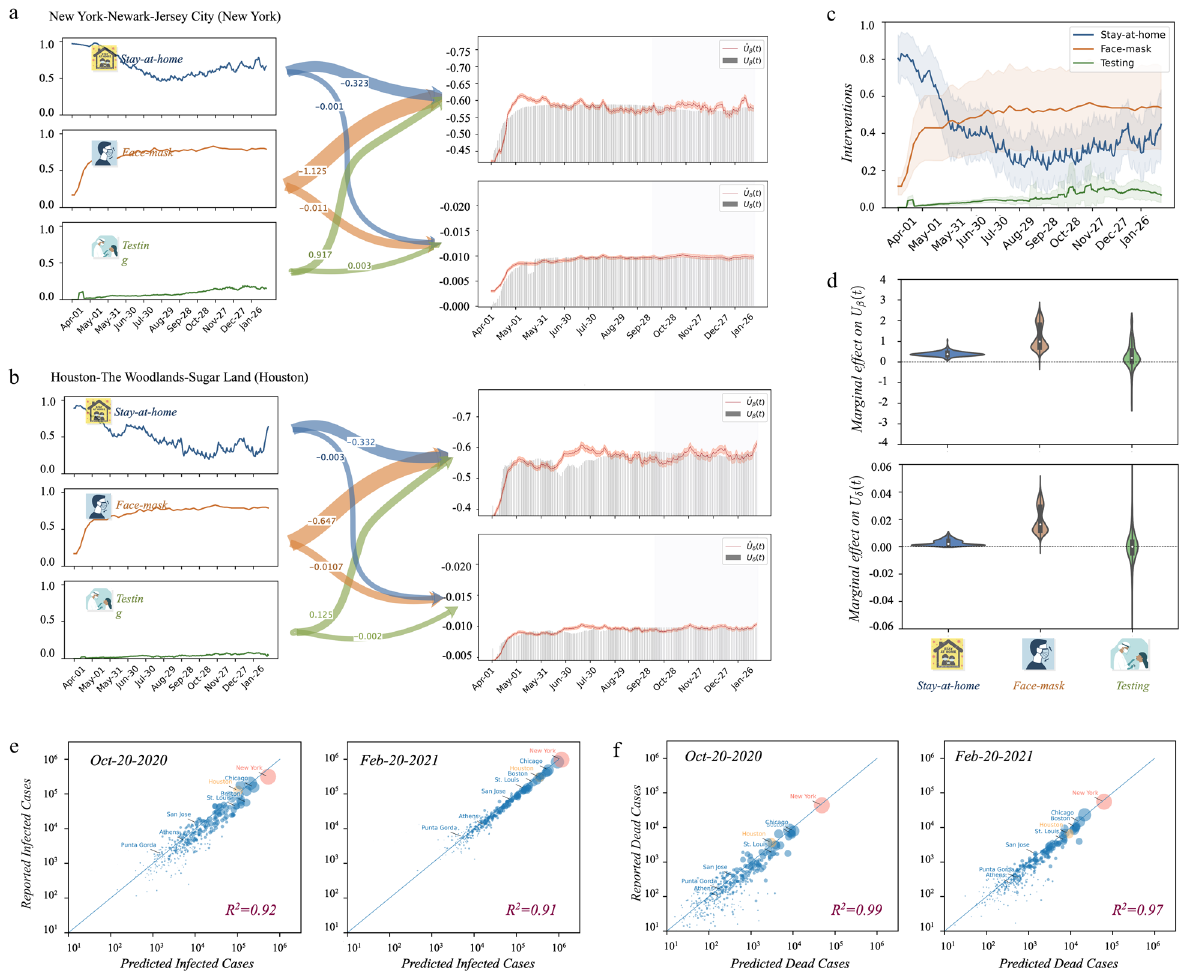
Fig. 4 The learned effects enable us to use the magnitude of NPIs to predict infection at each MSA. Using the 70% NPIs and infection data, we learned the NPIs' effects in the model of Eq. (17). Based on the learned effects, a , b illustrates how the magnitude of NPIs determine the controllers ( ^ U β ð t Þ and ^ U t Þ ) in the example MSAs. To test the accuracy of model, we compare [ ^ U t Þ and ^ U t Þ ] with analytical controllers [ U t ) and U t )] with the left 30% β ( δ ( δ ð β ð δ ð NPIs and infection data (vertical shaded area) in the right-side plots of a , b . c All MSAs' magnitudes of NPIs. The solid line represents the average, and the shaded area represents the standard variance for all MSAs. Though the large difference between MSAs' magnitudes of interventions, in d , the marginal effects for stay-at-home order and face-mask wearing are mainly negative. Testing, which may help to fi nd more infection and death, have either negative or positive effect. Thus, by taking the estimated controllers ^ U Θ ¼ ½ ^ U β ; ^ U γ ; ^ U δ (cid:3) as the input of the SIRD model, we fi nd the estimated infection/death assemble with reported infection/death with R 2 > 0.9, see the two example dates in e and f . Figure S2 shows the estimation accuracy for all others dates. It should be noted that as the ^ U γ keeps constantly proportional to ^ U β (see Fig. S1), there is no need for further exploring ^ U γ datasets for NPIs. The distributions of marginal effects across the three NPIs are shown in Fig. 4d. Most MSAs ’ marginal effects for stay-at-home order and face-mask wearing are negative. The statistics imply the generic feature of Eq. (17) in capturing NPIs ’ effects despite the huge regional heterogeneity of human behaviors. However, the average marginal effect of testing has ^ U t Þ , 73.5% of MSAs ’ testing ’ two opposite outcomes. For β ð marginal effects are positive, meaning 26.5% of them are negative. ^ U t Þ , 46.0% of MSAs ’ testing ’ marginal effects are positive, For δ ð meaning 54.0% of them are negative. The positive effects suggest that testing is favorable to fi nding more infections and deaths, while the negative effects show that testing reduces infection or death.